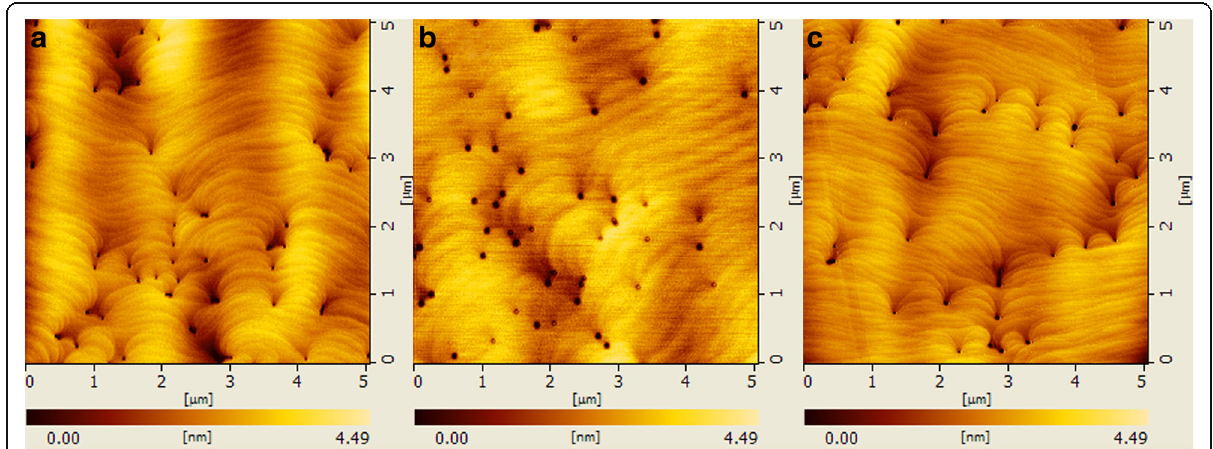
Fig. 5 The AFM images (5 × 5 μ m) of the a sample A, b sample B, and c sample